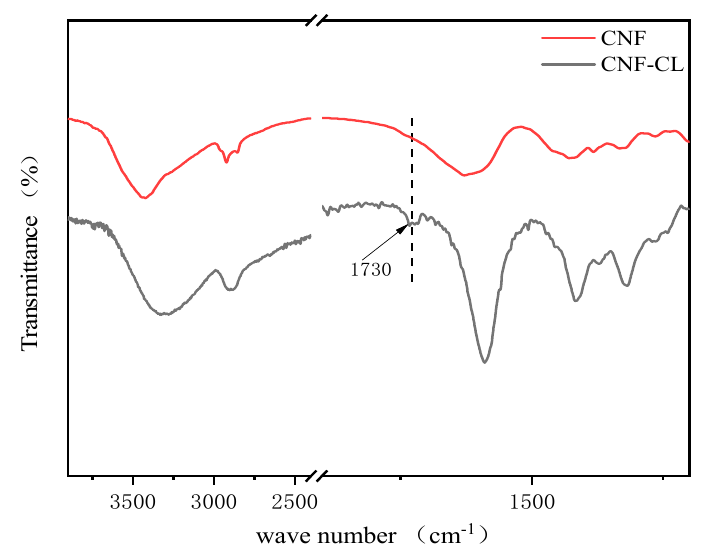
Figure 4. FTIR spectra of CNF and CNF − CL.